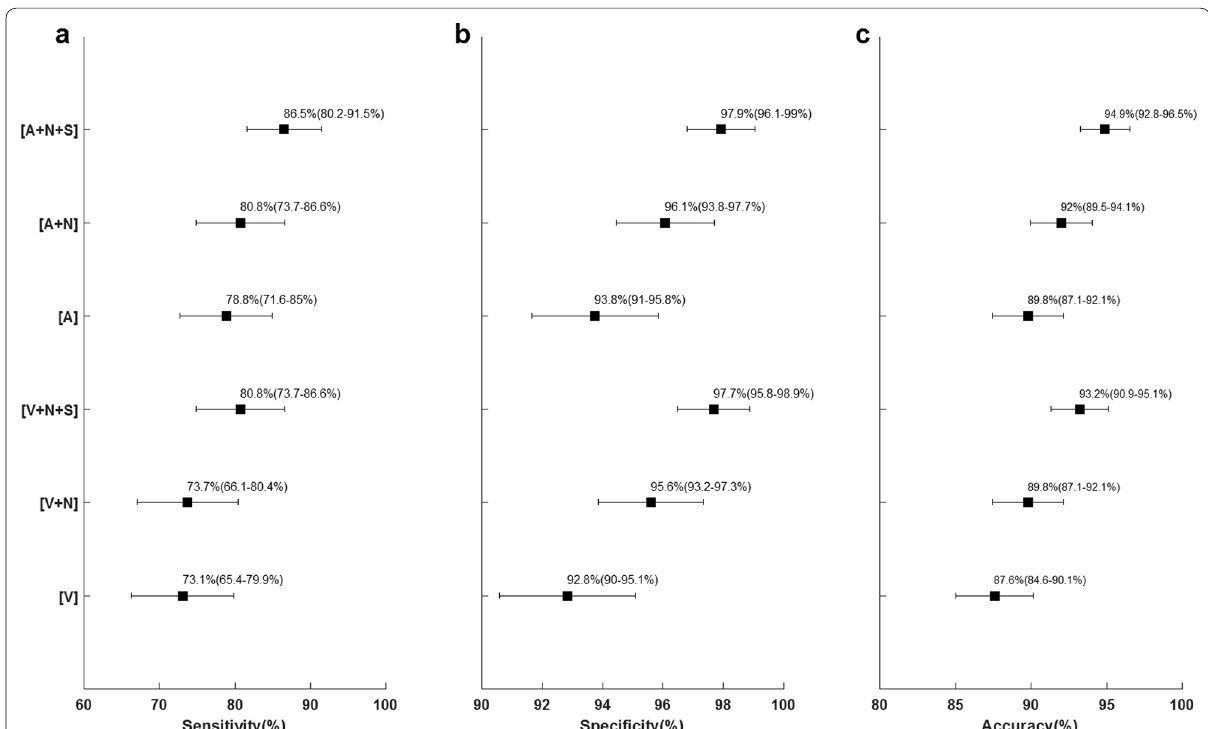
Fig. 3 Diagnostic sensitivity ( a ), specificity ( b ) and overall diagnostic accuracy ( c ), with 95% confidence intervals, for parathyroid adenoma localisation of the individual image